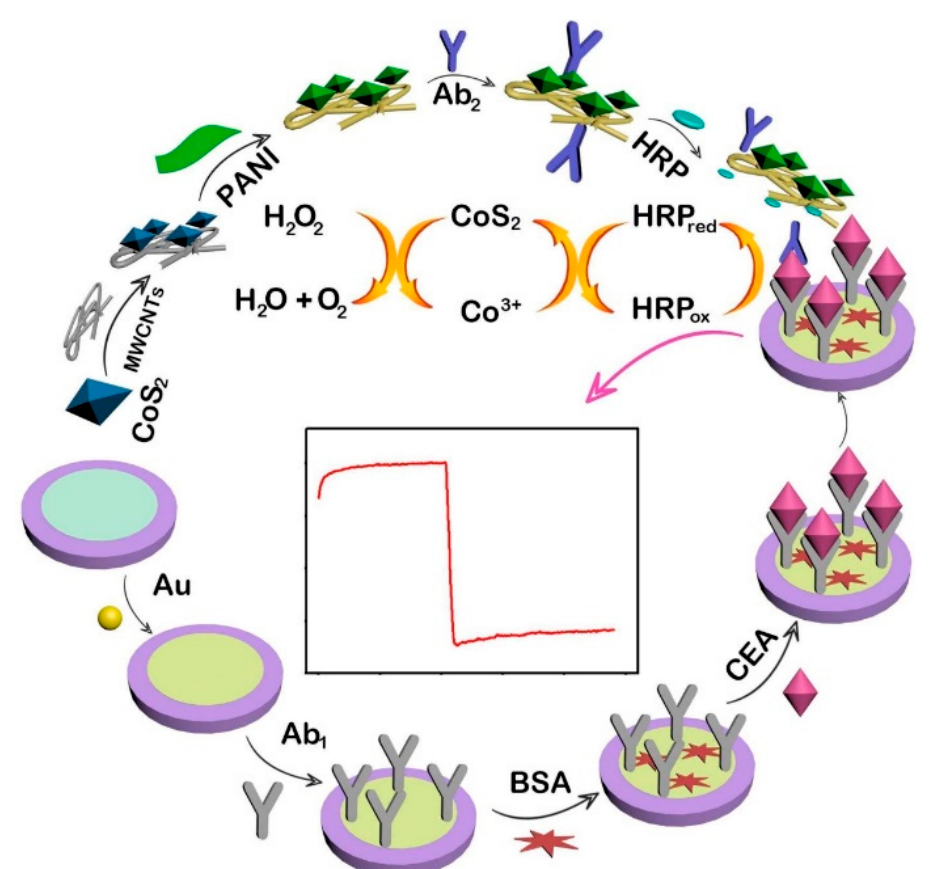
Figure 8. Electrochemical enzyme-assisted immuneosensor for carcinoembryonic antigen in blood serum. Glassy carbon electrodes are coated with AuNPs–antibodies conjugates which capture the target; the target in turn is sandwiched between a complex carbon NTs-CoS 2 -polyaniline-antibodies- horseradish peroxidase material that increases the electrochemical detection. Image adapted from [76] with permission of Royal Society of Chemistry, 2020.